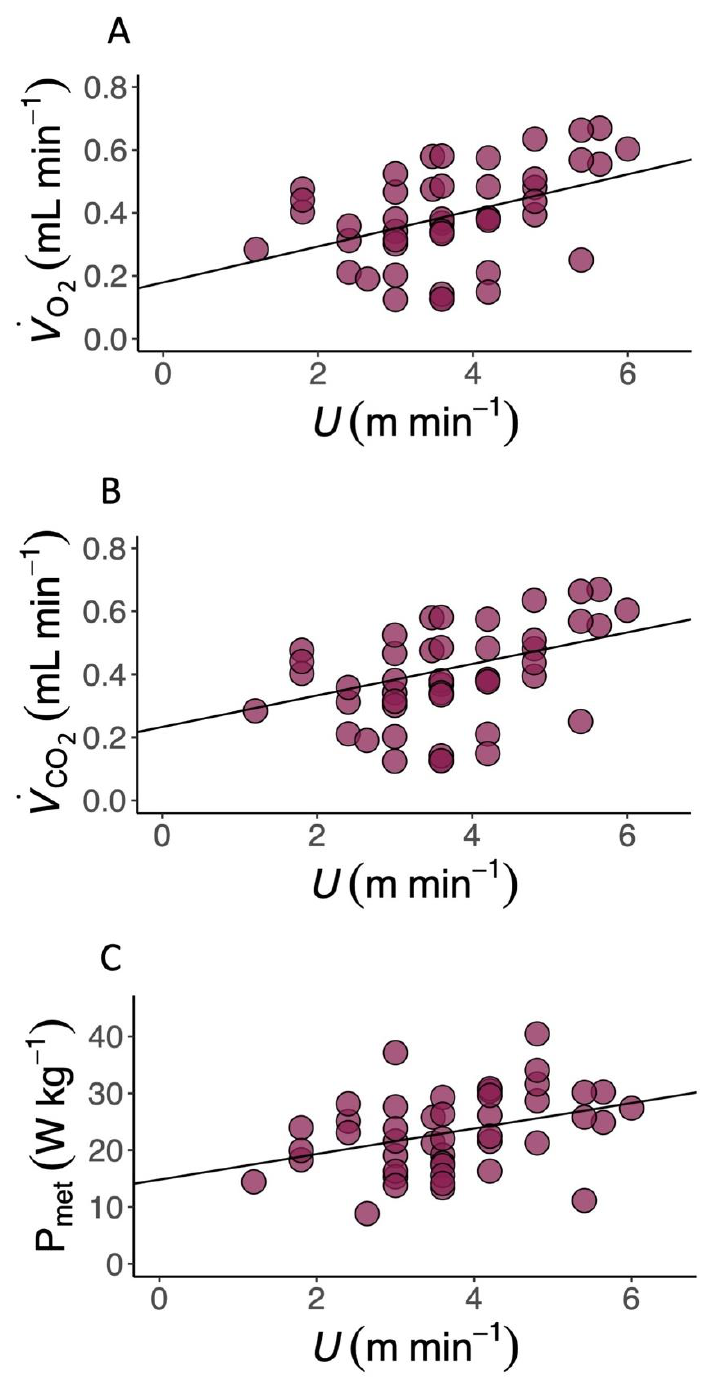
Figure 2. Locomotor energetics in the Mediterranean spur-thighed tortoise ( T. graeca ). ( A ) The rate of oxygen consumption ( V ̇ O ₂ , mL min −1 ), ( B ) the rate of carbon dioxide production ( V ̇ C O ₂ , mL min −1 ) and ( C ) mass-specific metabolic power (P met, W kg −1 ) during locomotion on a level treadmill over a range of speeds ( U , m min −1 ) in the Mediterranean spur-thighed tortoise ( T.graeca ). V ̇ O ₂ , V ̇ C O ₂ , and P met all increase linearly with U (Table 1).